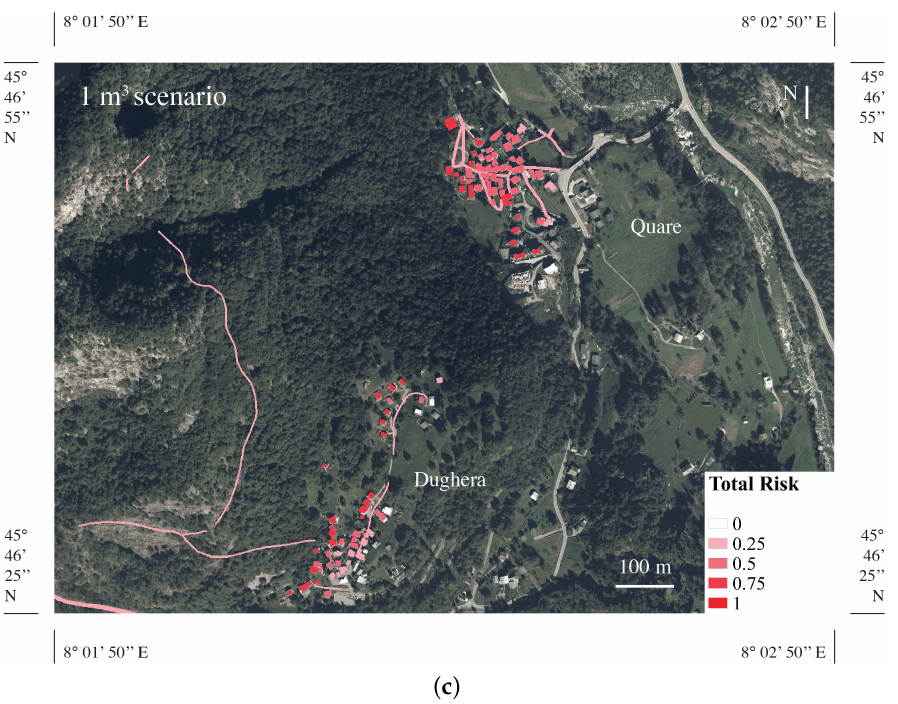
Figure 12. Comparison of the three scenarios in terms of total risk for the two hamlets of Quare and Dughera: ( a ) 0.1 m 3 scenario; ( b ) 0.5 m 3 scenario; ( c ) 1 m 3